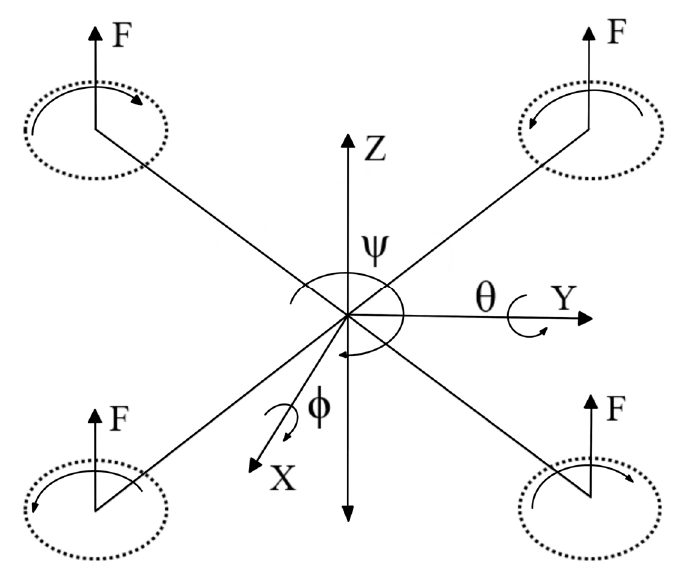
Figure 3. Quadrotor plant-protection UAV power model ( φ , θ , and ψ represent rolling angle, pitch angle, and yaw angle, respectively).